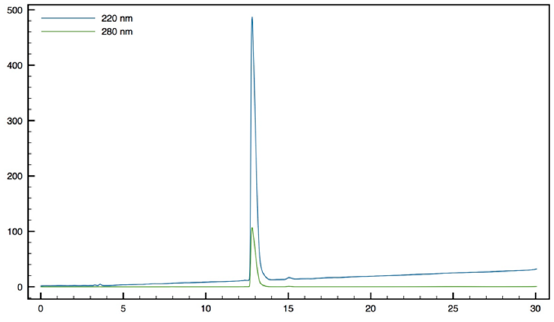
Figure 13. HPLC profile of H-Tbt - β 2,2 h bis-OrnOMe 9 Figure 13 . HPLC profile of H-Tbt- β 2,2 h bis-OrnOMe 9 .